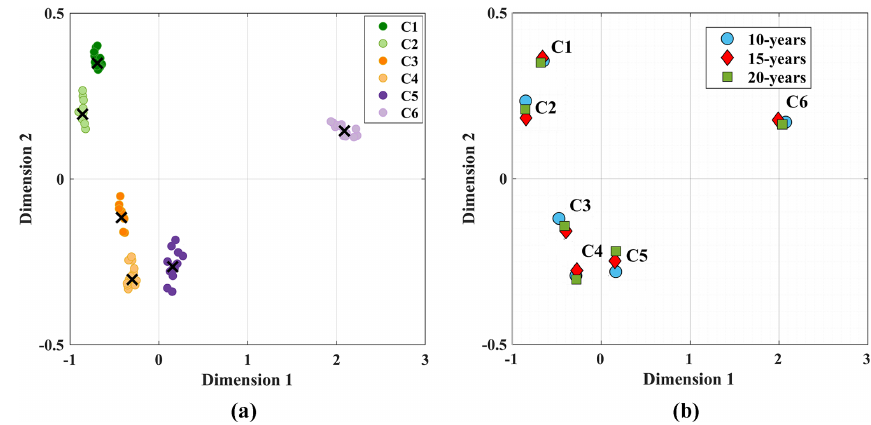
Figure 10. The sensitivity of the cluster centers to (a) the choice of decadal timeframe for clustering and (b) the length of the timeframe used for analysis. In panel (a) dots show the two-dimensional scaling of the cluster centers in which distances between dots represent dissimilarities between cluster centers. Black crosses show the centers identified by choosing the first decadal timeframe. Panel (b) shows the two-dimensional scaling of the cluster centers considering 10-, 15-, and 20-year